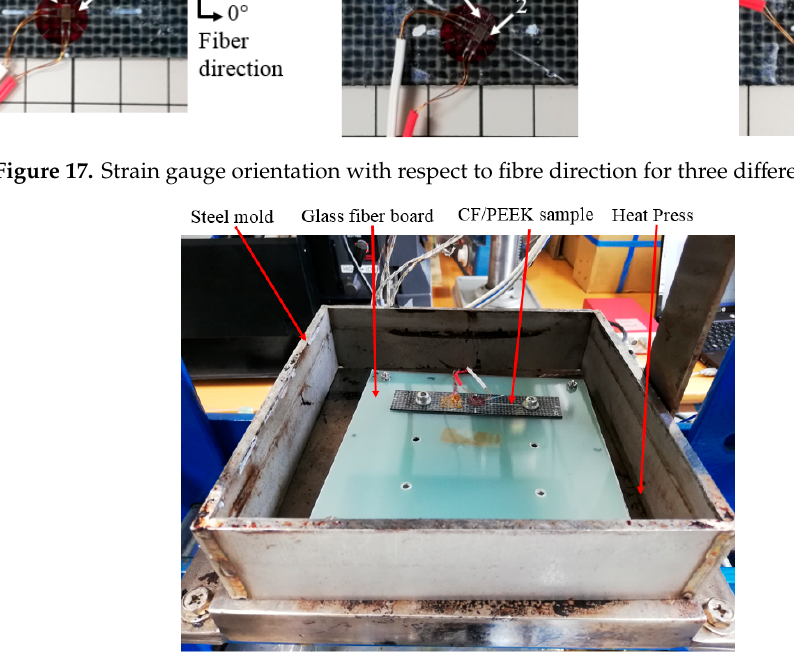
Figure 18. Test assembly for strain gauge offset test.